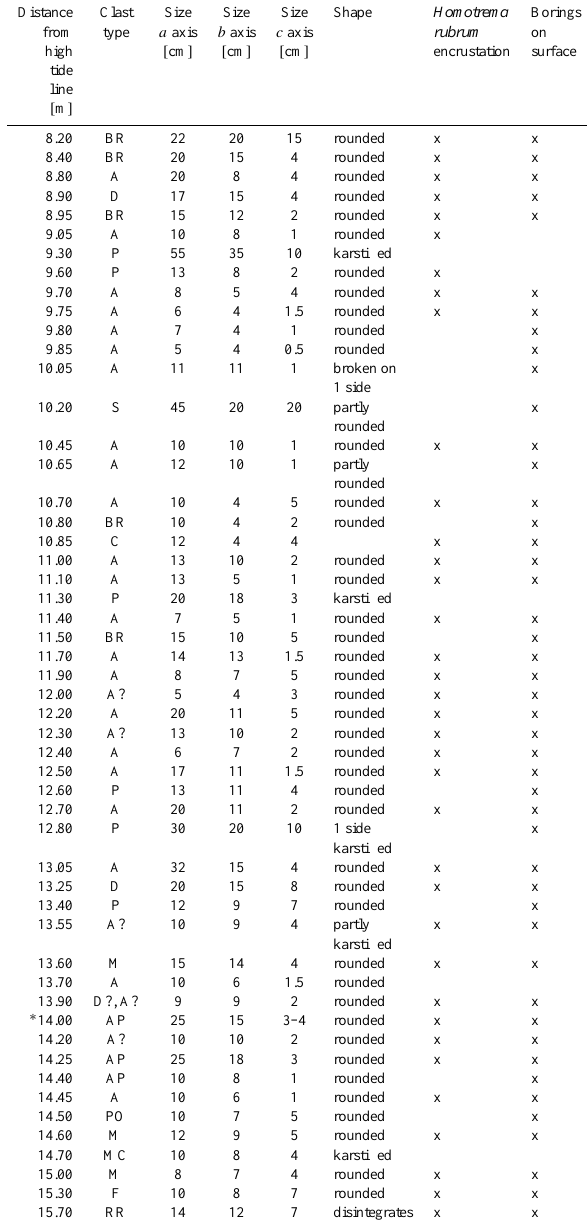
Table A1. Clast parameters of ridge transect I (the star symbol ∗ marks the crest of the